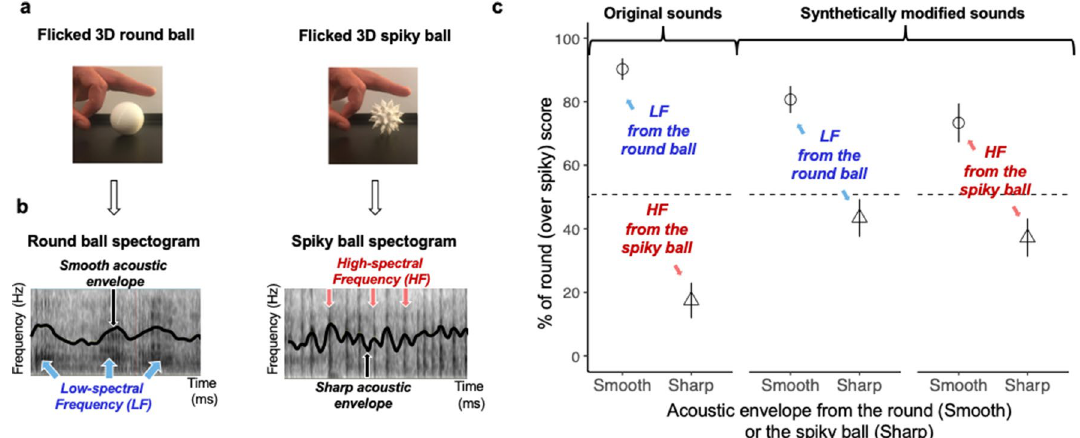
Figure 5. Stimuli and results from the Rolling Balls Experiment. ( a ). Picture of the two 3D balls (one round, one spiky) propelled by a flick on a plane shelf used in the forced-choice task. The balls were made with a 3D printer. ( b ) Examples of spectrograms of two original sounds produced by the round and the spiky balls rolling on a shelf. The acoustic envelope, drawn in black, is smoother for the round ball. Darker areas represent more intense low- (for the round ball) or high- (for the spiky ball) frequency bands. ( c ) Experimental round score averaged across participants for the Rolling Balls Experiment. These scores are represented as a function of Acoustic Envelope (Smooth—circles vs. Sharp—triangles) and Spectral Balance (Low-Frequency, LF, in blue vs. high-frequency, HF, in red) for the original and the synthetically modified sound stimuli. Big circles and triangles show overall means. Error bars are standard